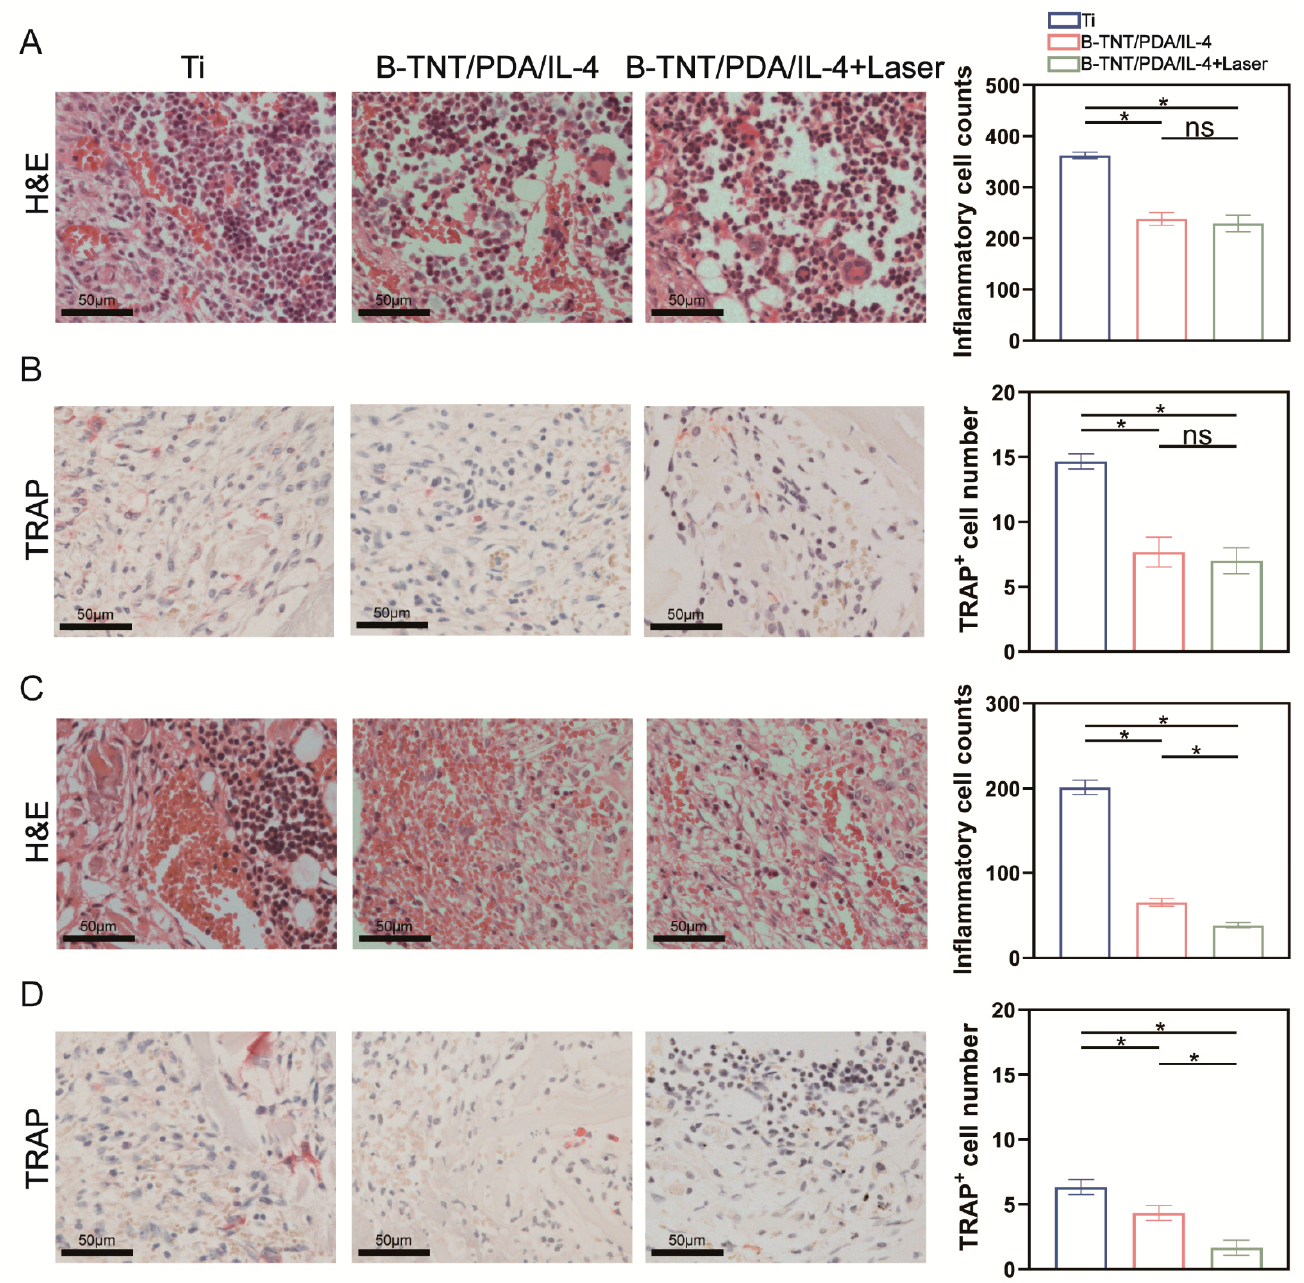
Figure 7. ( A ) Hematoxylin-eosin (H&E) staining images and quantitative assessment of inflammatory cells after 3 days of implantation. ( B ) Tartrate-resistant acid phosphatase (TRAP) staining images and quantitative assessment of TRAP + cells after 3 days of implantation. ( C ) H&E staining images and quantitative assessment of inflammatory cells after 7 days of implantation. ( D ) TRAP staining images and quantitative assessment of TRAP + cells after 7 days of implantation. * indicates statistical difference between groups ( p < 0.05); ns means no statistical difference between